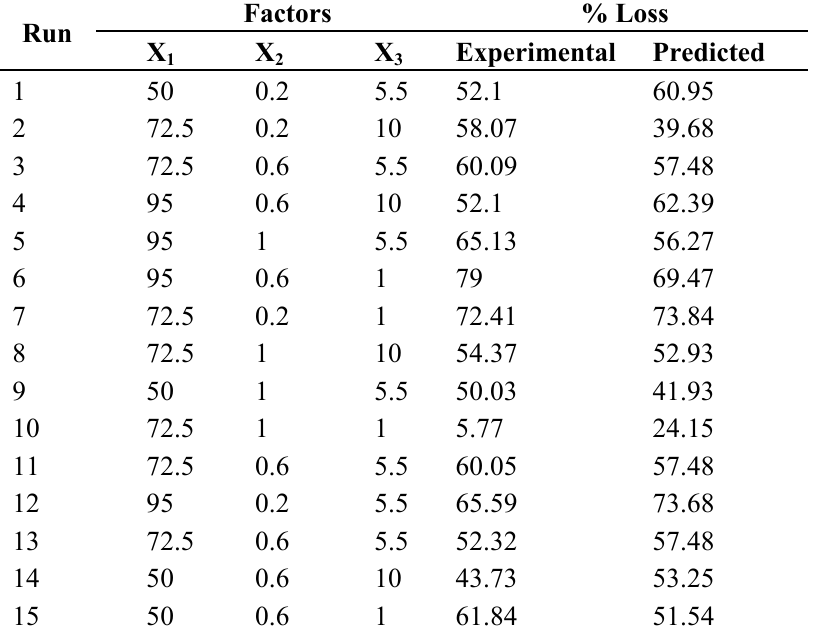
Table 3. Box–Behnken design matrix for the three factors and their experimental results for